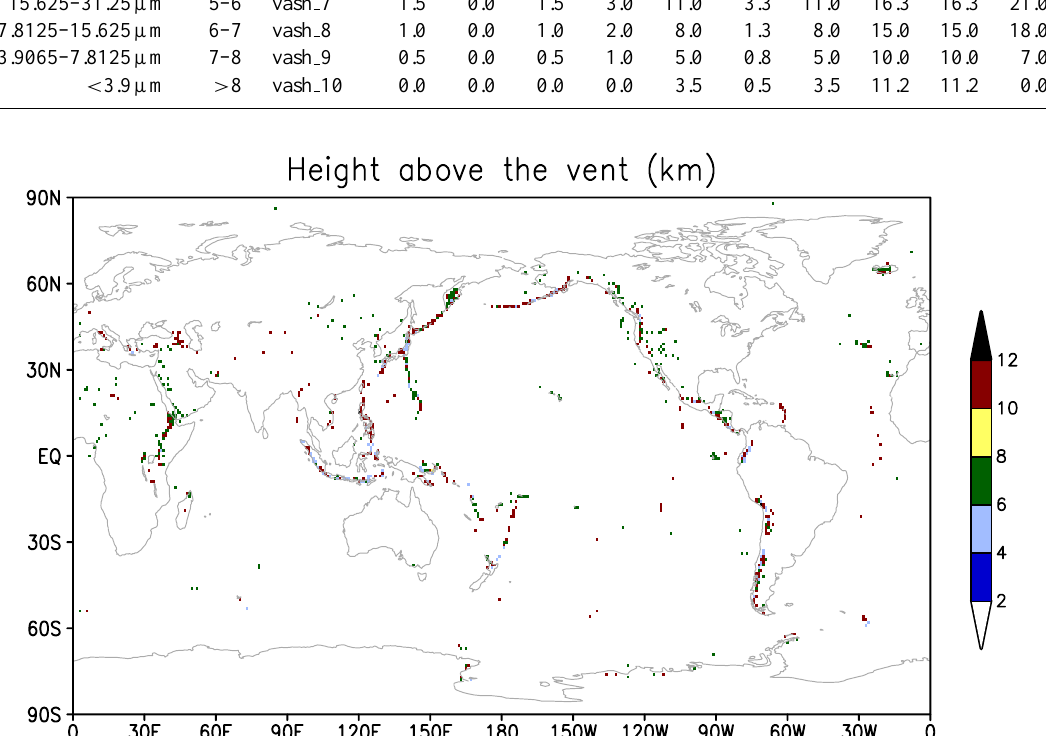
Fig. 2. The global dataset of volcanoes described in Mastin et al. (2009) and included in WRF-Chem model to simulate ash cloud movement. The figure shows the plume height above the vent prescribed for each volcano with past and potential future